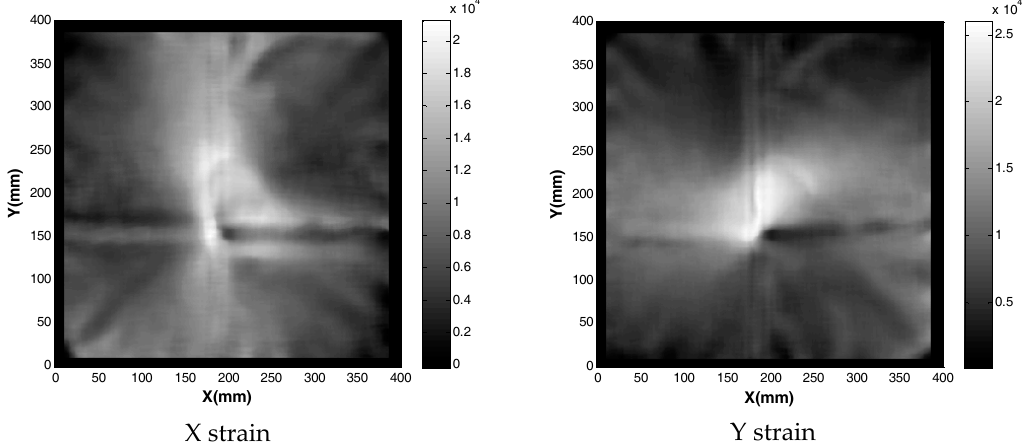
X strain Y strain X(mm) Figure 20. Strain field obtained when membrane was loaded with two spacers added beneath the X(mm) X strain Y strain membrane. X strain Y strain Figure 20. Strain field obtained when membrane was loaded with two spacers added beneath the Figure 20. Strain field obtained when membrane was loaded with two spacers added beneath Figure 20. Strain field obtained when membrane was loaded with two spacers added beneath the membrane. the membrane. membrane.